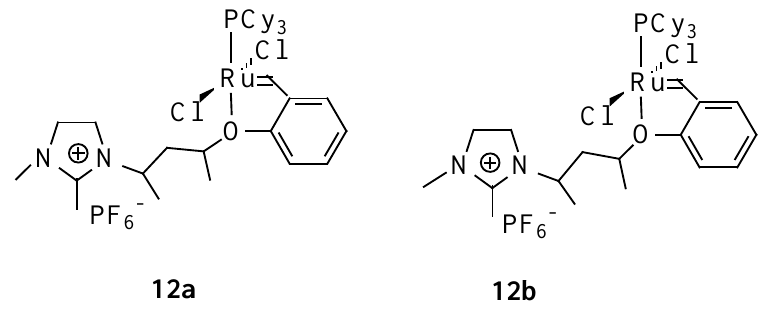
Figure 7. Ru-imidazolium-tagged carbene complexes [65]. Figure 7. R u-imidazolium-tagged carbene complexes [65]. Figure 7. R u-imidazolium-tagged carbene complexes [65].